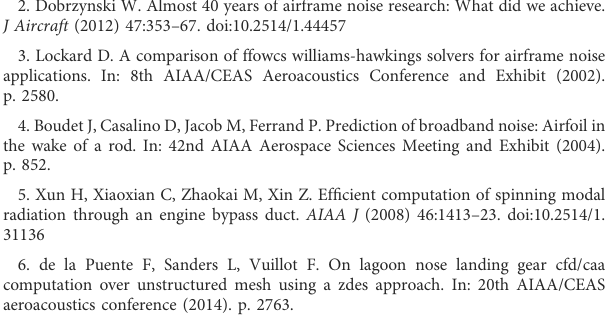
The Q-criteria contour surfaces (Figure 16) obtained from NLAS show that there are both large-scale vortices and small- scale vortices generated in the wake of the cylinder. With the increase of the offset distance, the interaction between the wake of the cylinder and the leading edge of the airfoil becomes smaller. So the sound pressure decreases, as predicted in Figure 15.